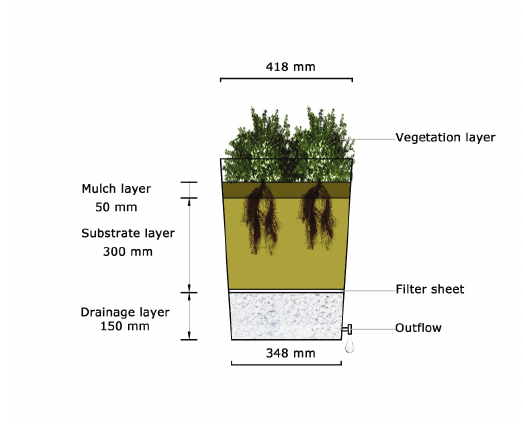
Fig. 1 ­ Schematic drawing of the bioretention pot prototype. Not to scale.